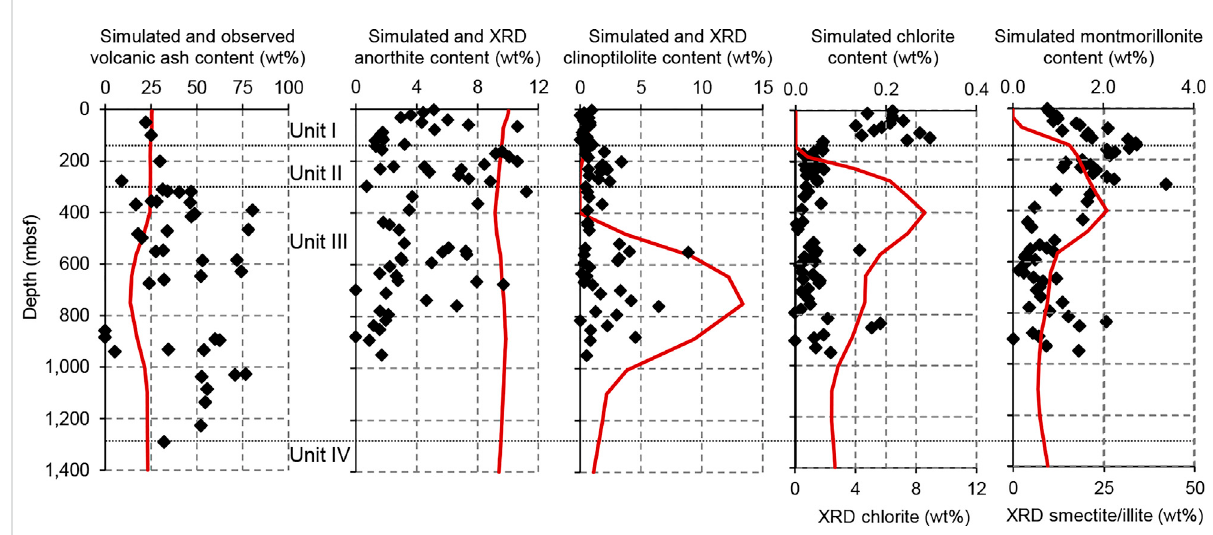
FIGURE 8 Simulated depth pro fi les of the relative amount of volcanic ash, anorthite, clinoptilolite, chlorite (clinochlore 14A), and smectite (red lines). Observed vitric content (expressed in weight percent), and XRD-estimated content of anorthite, clinoptilolite, chlorite and smectite, corrected for the observed vitric content (black diamonds). Note the different scales for XRD-estimated and simulated amount of chlorite and